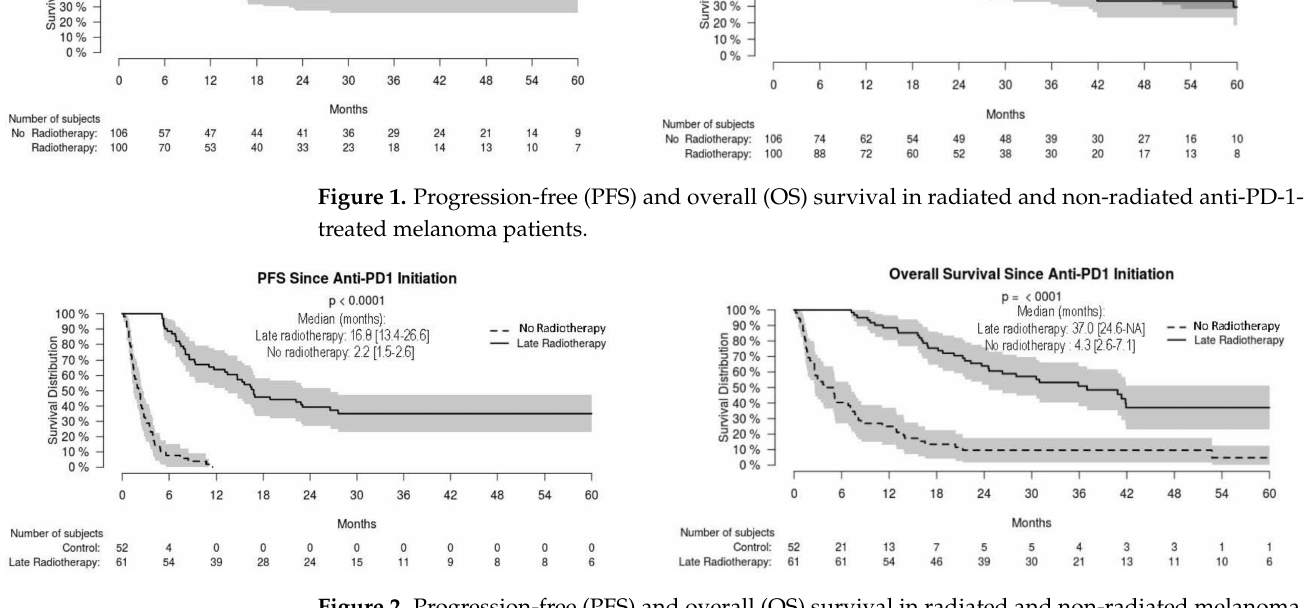
Figure 2. Progression-free (PFS) and overall (OS) survival in radiated and non-radiated melanoma patients with anti-PD-1 treatment failure.